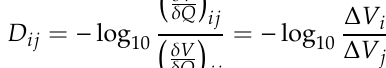
Table 3. Simulation environment details of RTHS and the large-scaled RTS for Shin-Jecheon SVC HILS-DPT.